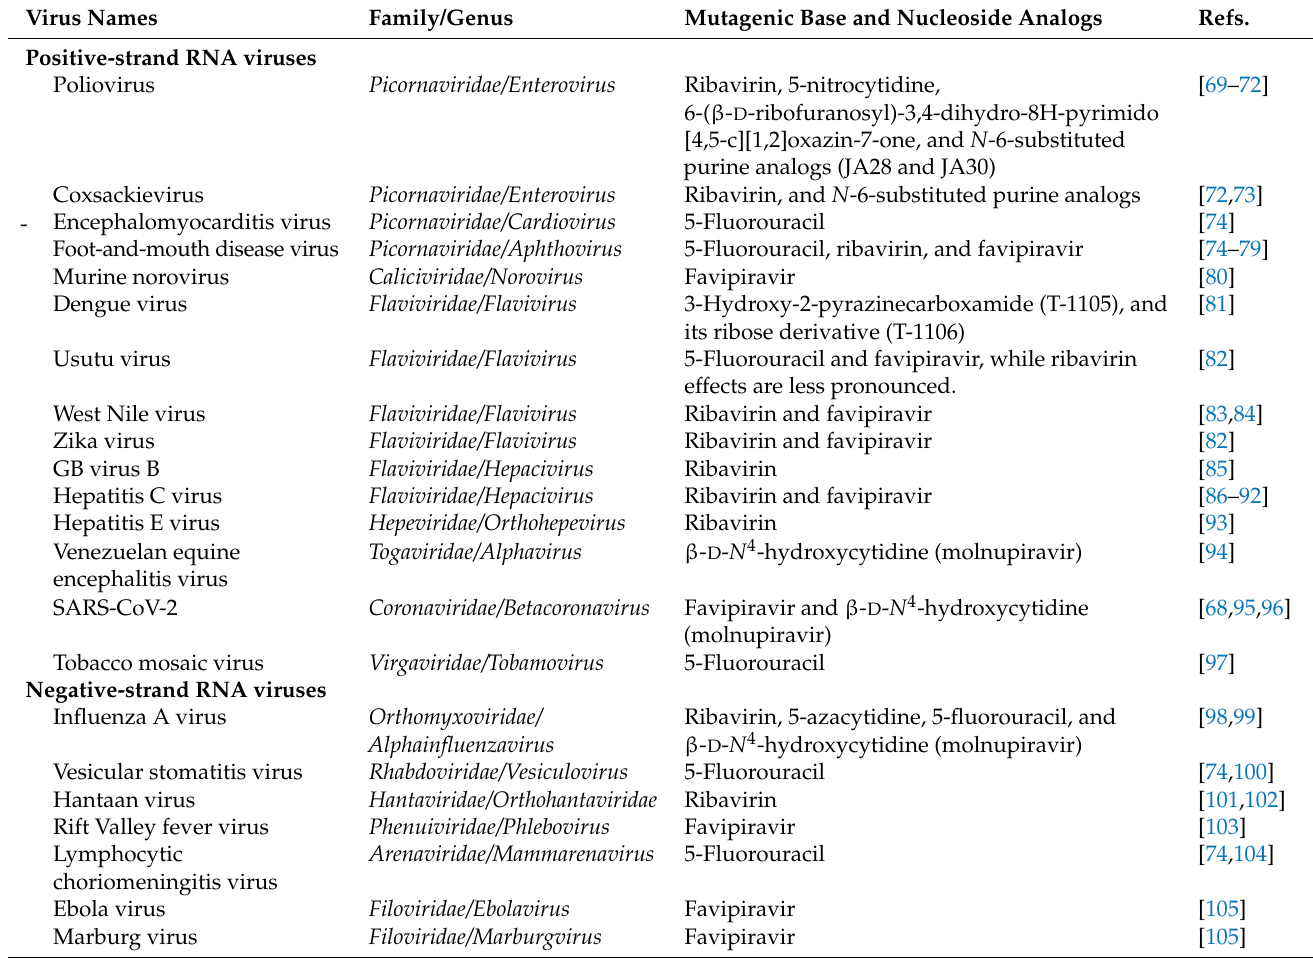
Table 2. Studies showing lethal mutagenesis in single-stranded RNA viruses grown in the presence of mutagenic base and nucleoside